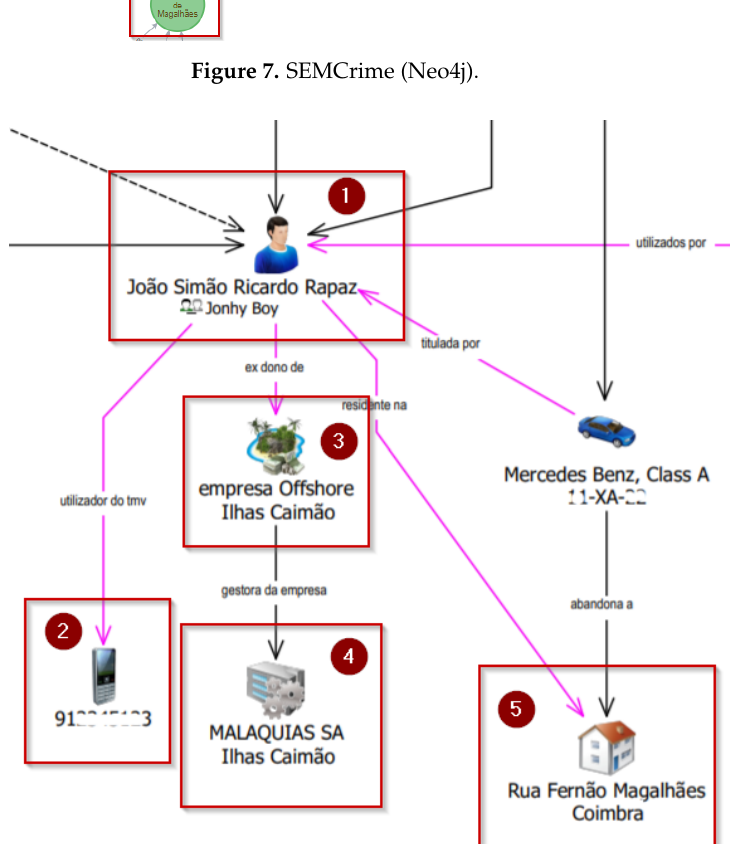
Figure 8. IBM™ i2 Analyst’s